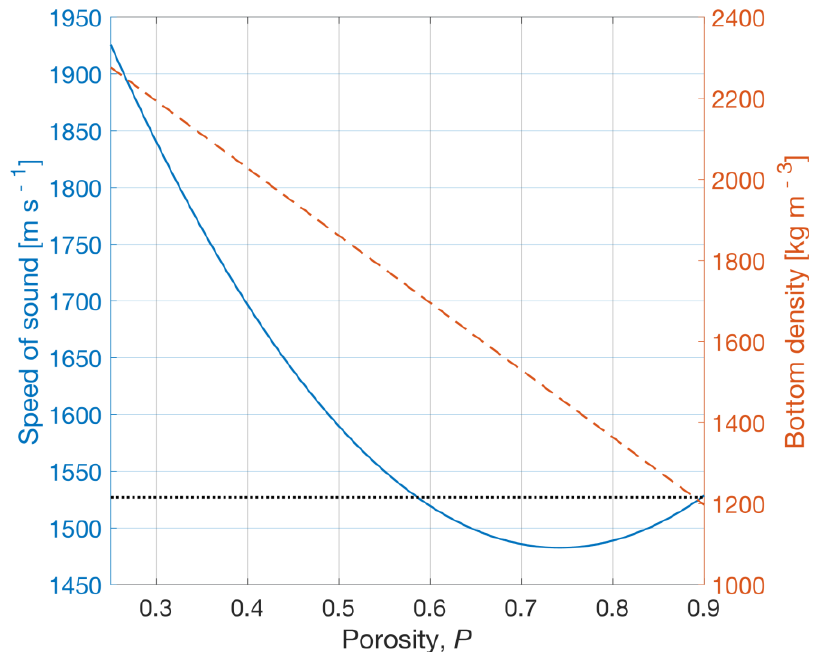
Figure 14. The sound speed 𝑐 𝑏 (left axis, blue solid line) and the bottom density 𝜌 𝑏 (right axis, red dashed line) vs. the porosity 𝑃 , calculated with the empirical Akal formula [13] for 1200 m bottom depth and the sound speed of water near the bottom of 1527 m s −1 (black dotted line). Sound speed profile in the water is after [54].